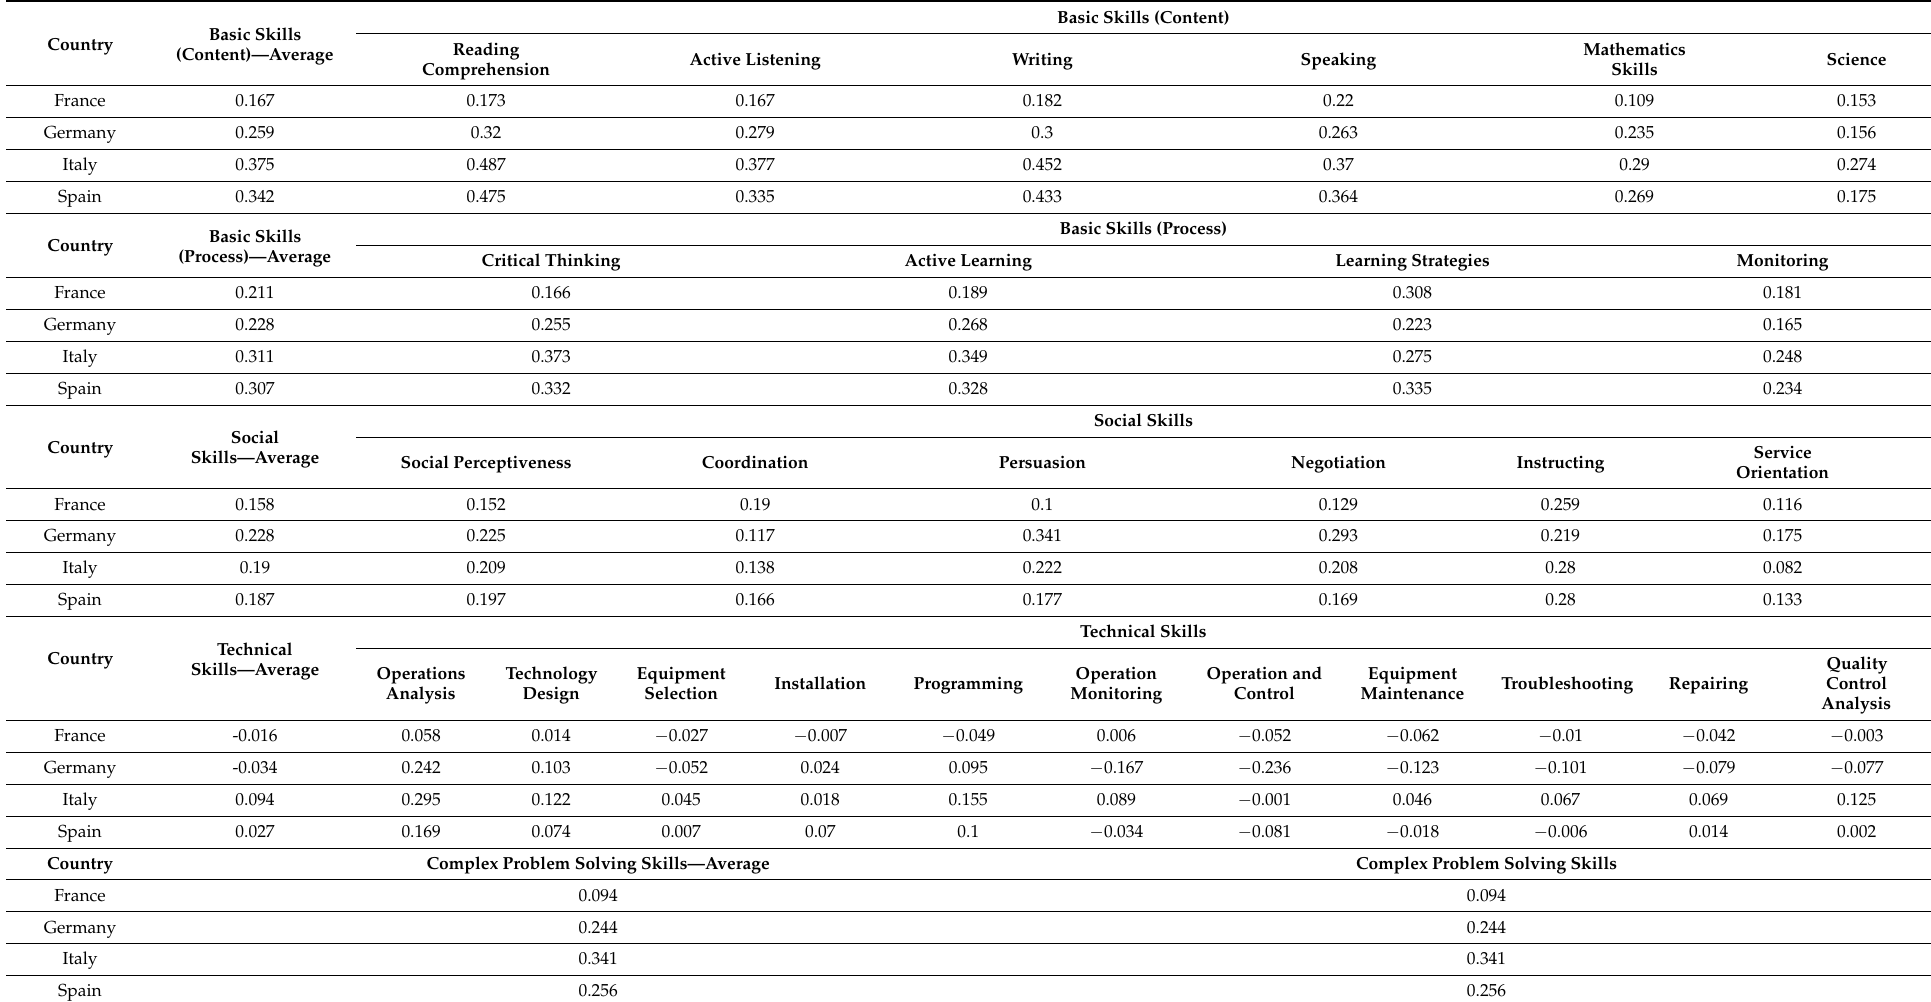
Table 6. Skills comparative view. Source: own elaboration based on data from OECD data